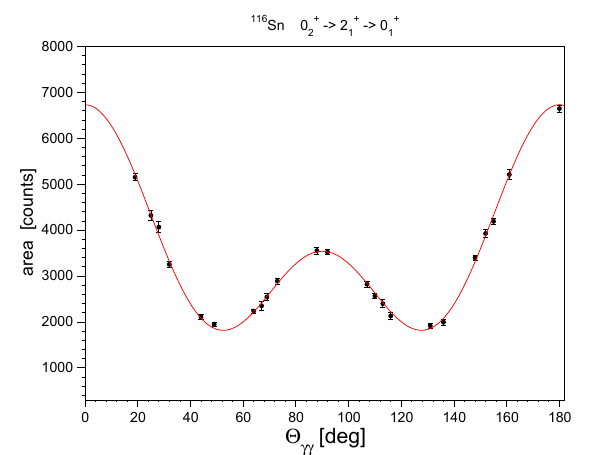
Figure 5: Angular correlation plot obtained for the 0 + 116 Sn. The calculated a values are used to fit the q values (see